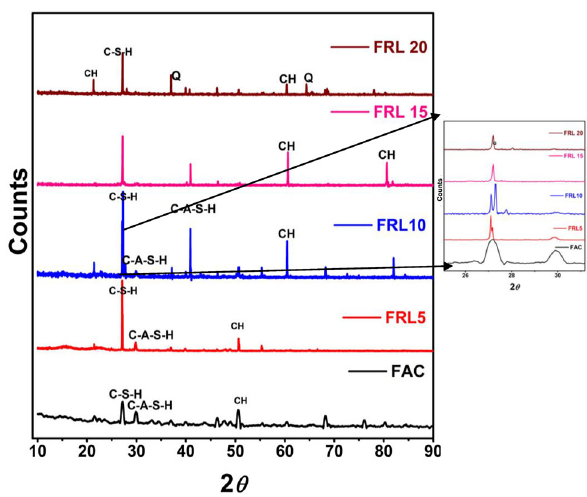
Fig. 4 XRD Pattern for Various mix of concrete.